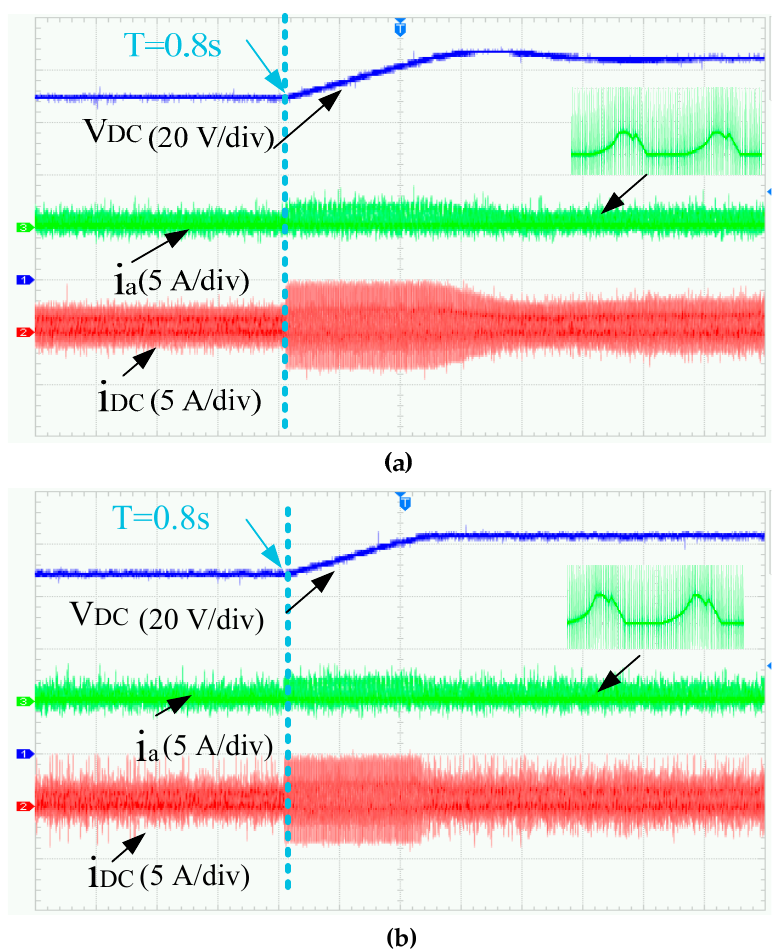
Figure 13. The experimental waveforms of SRG control with variable voltage: ( a ) the waveforms under PI controller; ( b ) the waveforms under PR controller.